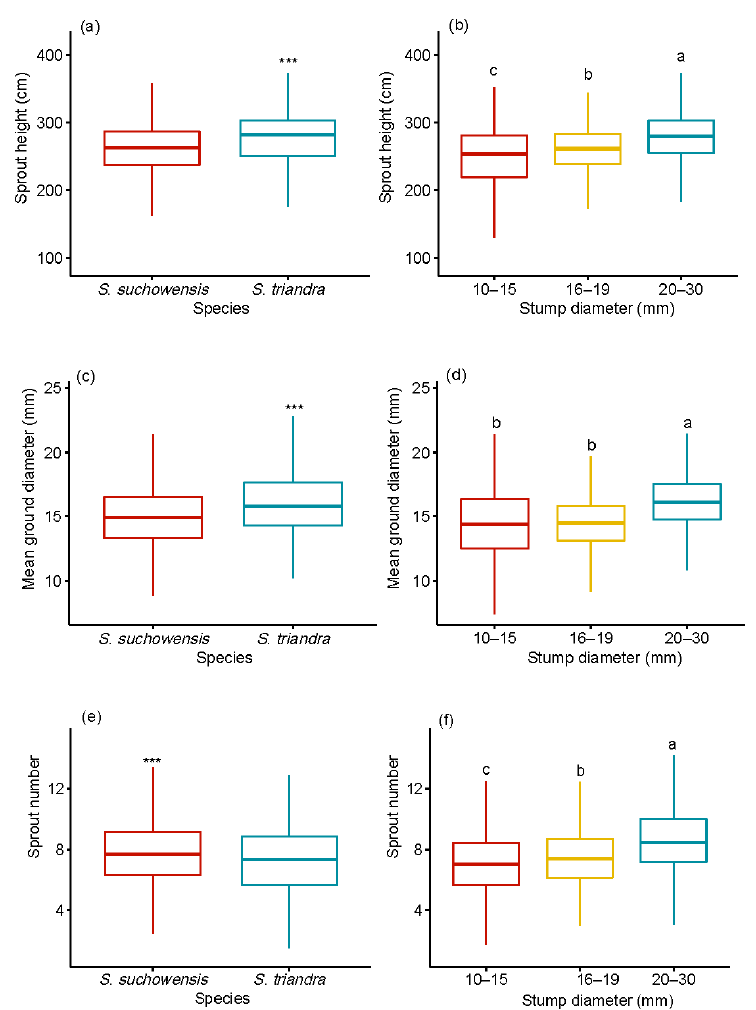
Figure 1. Effect of stump diameter and species on sprout height ( a , b ), sprout basal diameter ( c , d ), and sprout number ( e , f ). Notes: Comparisons between species within growth traits, including sprout height, sprout basal diameter, and sprout number, were performed using the pairwise t -test. *** p < 0.001. Different letters above bars indicate statistical differences among stump diameter classes in accordance with Tukey’s honestly significant difference (HSD) mean